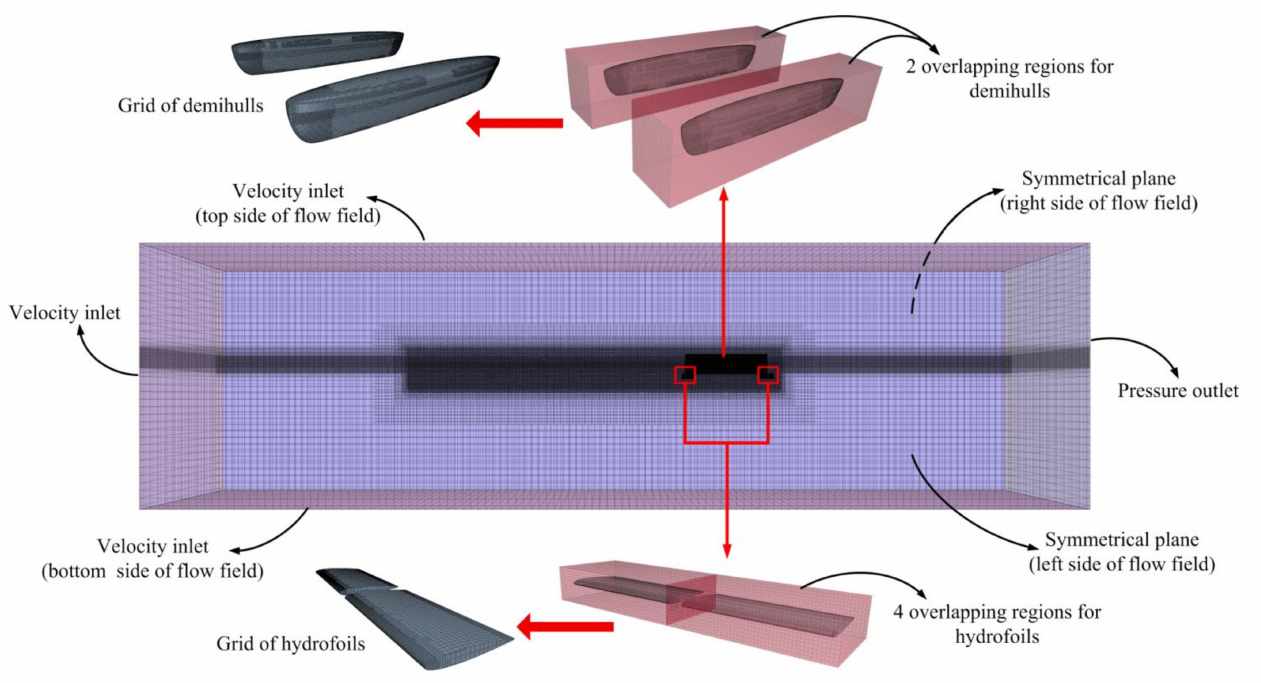
Figure 5. Boundary conditions and grid plan of flow